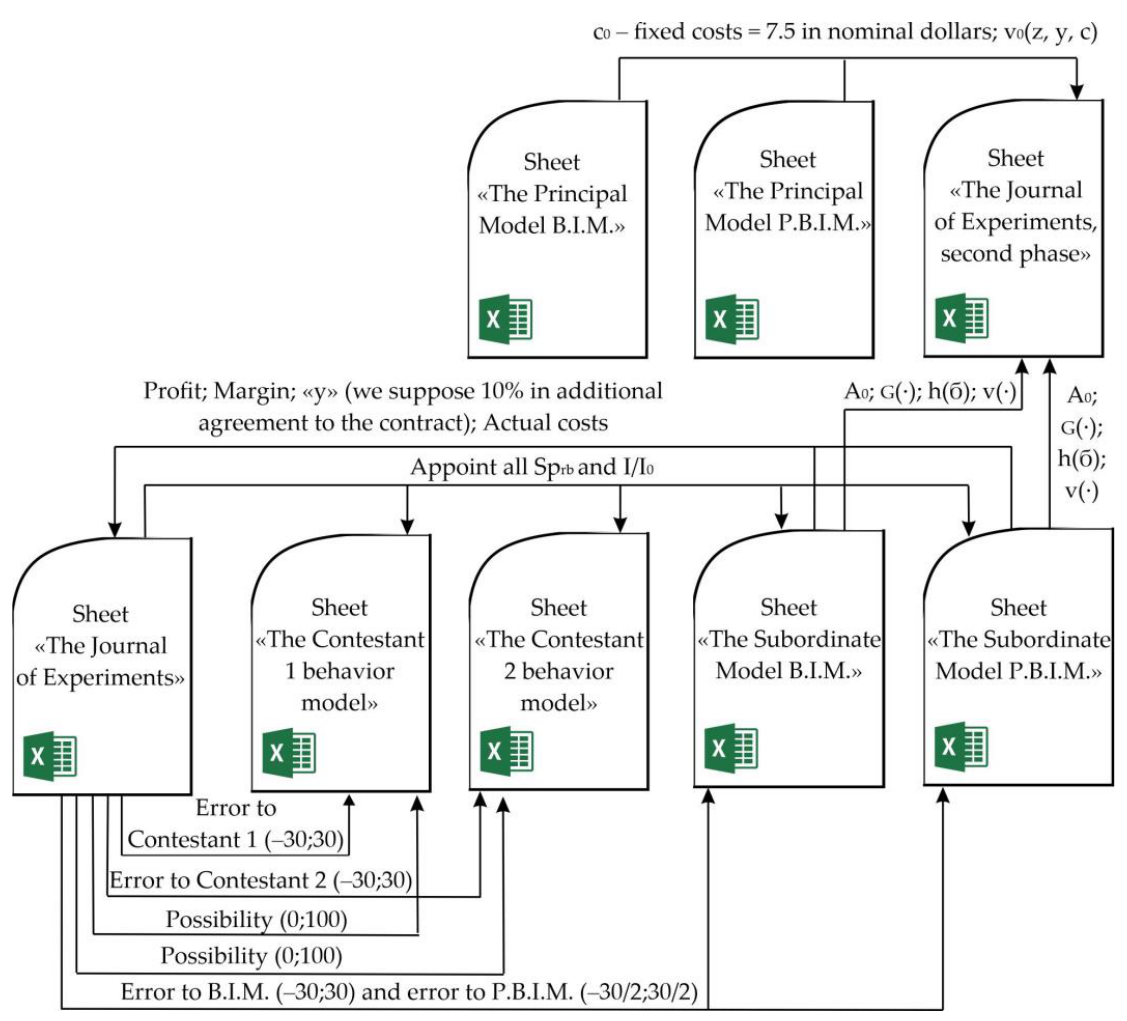
Figure 2. Structure of variables relations in the computer simulator developed in Microsoft Excel ® 2010 spreadsheets.